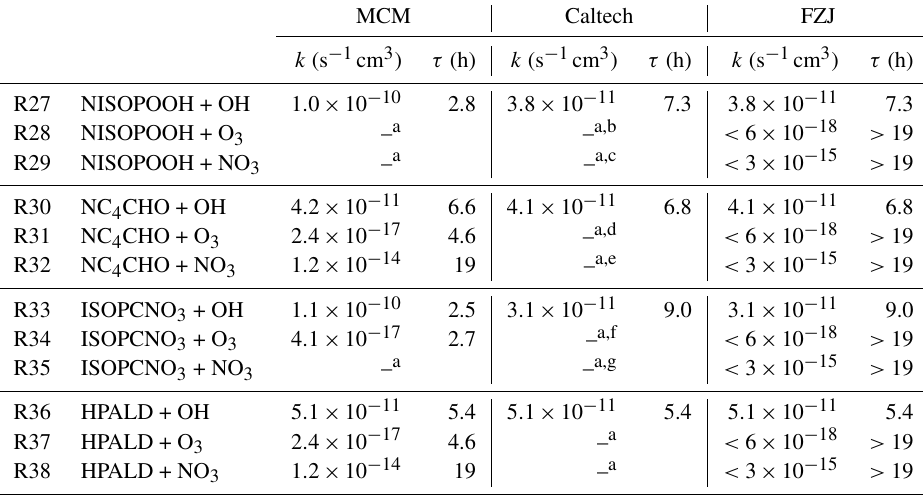
a Not implemented; b 2 . 8 × 10 − 19 s − 1 cm 3 , Wennberg et al. (2018); c 3 . 0 × 10 − 14 s − 1 cm 3 , Wennberg et al. (2018); d 4 . 4 × 10 − 18 s − 1 cm 3 , Wennberg et al. (2018); e 1 . 1 × 10 − 13 s − 1 cm 3 , Wennberg et al. (2018); f 2 . 8 × 10 − 19 s − 1 cm 3 , Wennberg